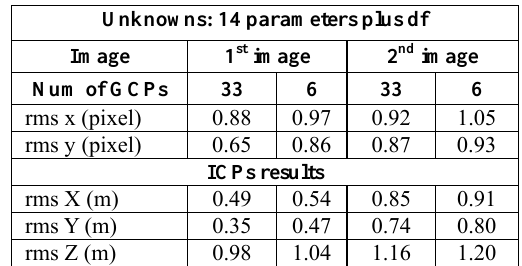
Figure 5. RMS in Y-coordinate of ICPs as function of GCP number